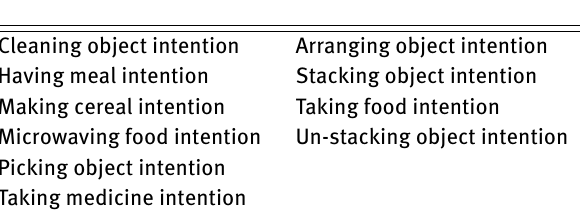
Table 1: Correctly recognized and incorrectly recognized intents based on proposed approach.